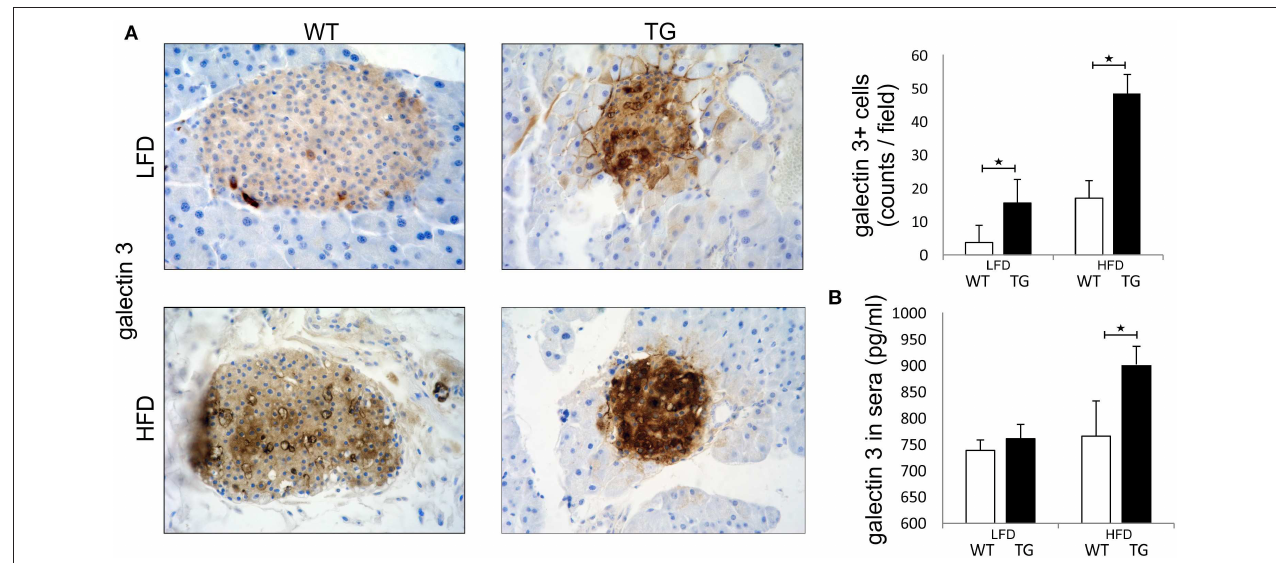
FIGURE 1 | Expression of galectin 3 is increased in mice on a high-fat diet. Immunohistochemical expression of galectin 3 + cells in islets. The number of galectin 3 immunopositive cells was significantly higher in TG mice compared to WT mice on standard diet. On HFD, the number of galectin 3 immunopositive cells in islets increased in both groups and was significantly higher in TG mice compared to WT (A) . Levels of galectin 3 in sera. By week 16 of HFD, levels of galectin 3 in sera were also significantly higher in TG mice compared to WT mice (B) . An analysis was performed by light microscope using a 40X magnifying lens. Results are presented as a mean count of positive cells per field on 10 non-overlapping fields/section. Data from two experiments with 10–15 mice per group are shown as mean ± SEM; by Mann-Whitney U -test and independent-sample Student’s t -test; * p < 0.05.